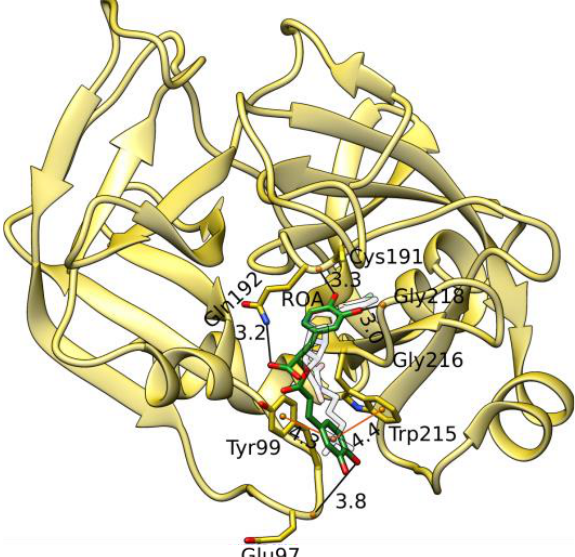
Figure 6. A docked structure of rosmarinic acid (carbon in green sticks) in the factor X binding site (gold cartoons and sticks) (PDB ID 2JKH). H-bonds are shown with black, and π – π interactions are shown with orange lines (distances in Å). Using transparent sticks, we also depict the crystal ligand structure (PDB ID BI7).